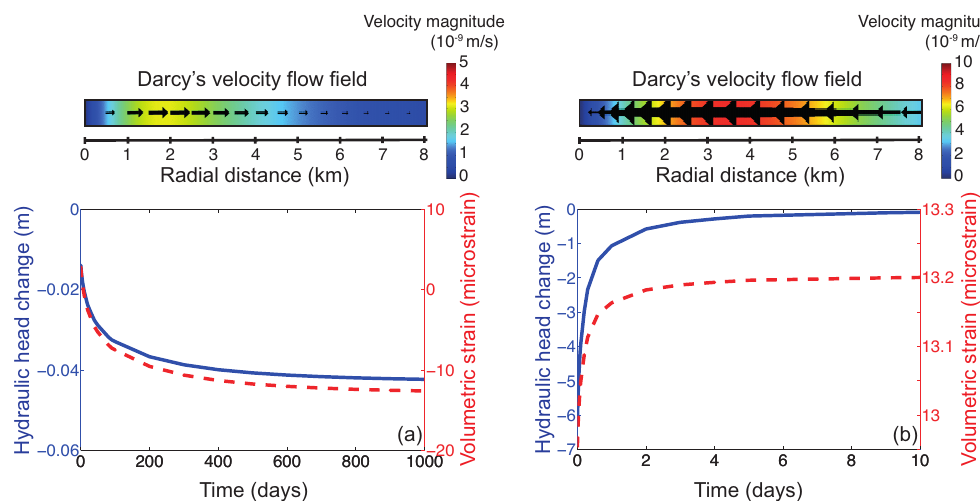
Figure 3. Upper graphs: porous flow pattern shown for the reference simulation at t = 0 . 1days. (a) pyroclastic aquifer, (b) lava flow aquifer. Arrows indicate flow direction at the point where the arrow is attached, their length is proportional to flow velocity (note: different scales for a and b ), colours show velocity magnitude. Lower graphs show hydraulic head and strain development with time in the centre of the aquifers. Note the different time scale – flow processes are faster in the lava flow aquifer.